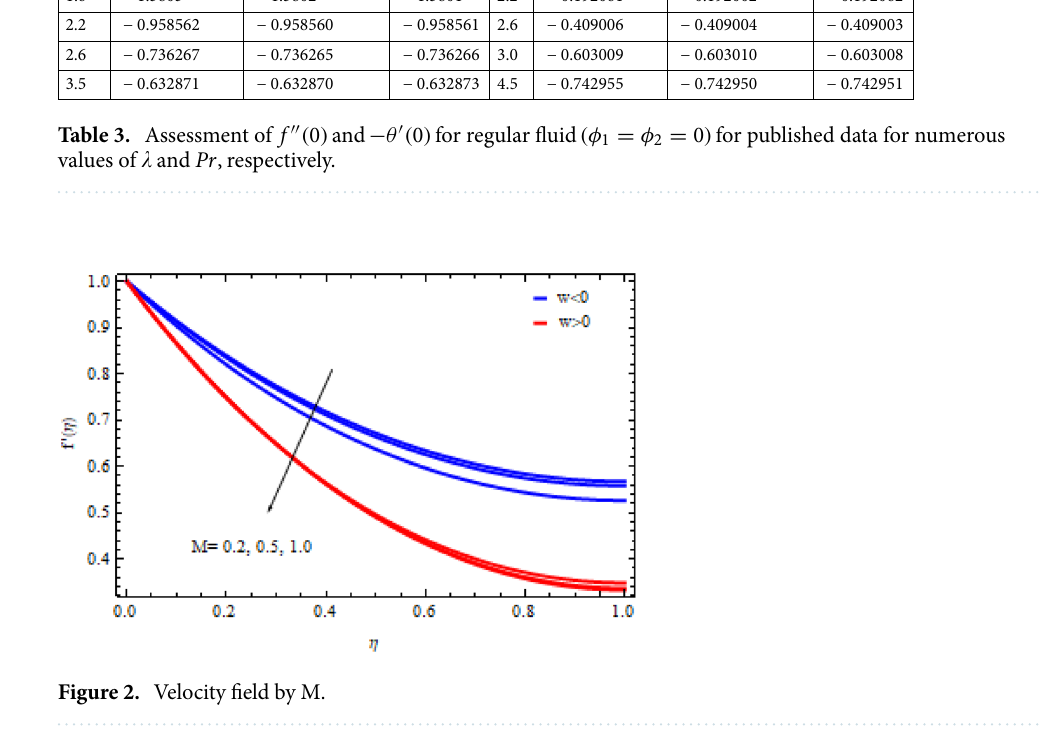
Figure 2. Velocity field by